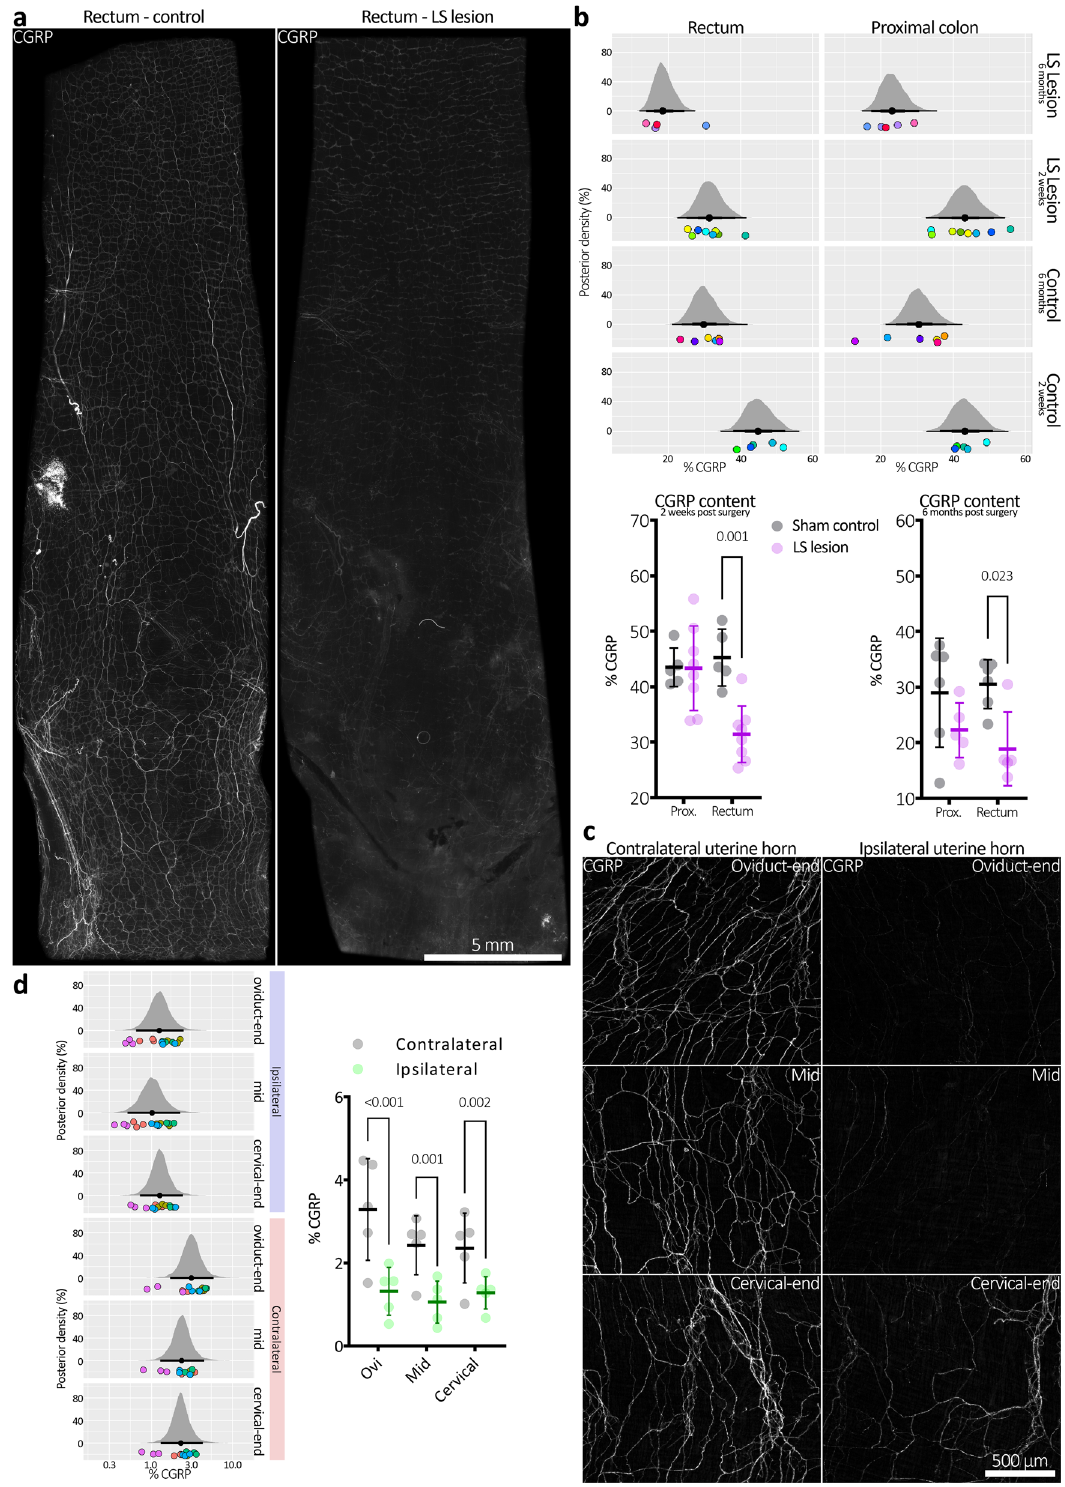
VMRs to electrical stimulation of rectum and bladder 6 months after surgery were performed by anaesthetising with pentobarbital sodium (200 – 300 μ l of 6 mg/ml, ~40 – 60 mg/kg); depth of anaesthesia was assessed by lack of response to hindlimb or tail pinch. Electromyographic electrodes were placed into the left external oblique muscle and a reference electrode placed in the quadriceps muscle of the opposing leg. EMG recordings were acquired at 20 kHz and recorded on a PC running LabChart 7 Pro software and high pass fi ltered (100 Hz). To calculate VMR the analogue EMG signal was recti fi ed and AUC (in µV.s) was calculated in LabChart 7 Pro (ADInstruments, Australia). A pair